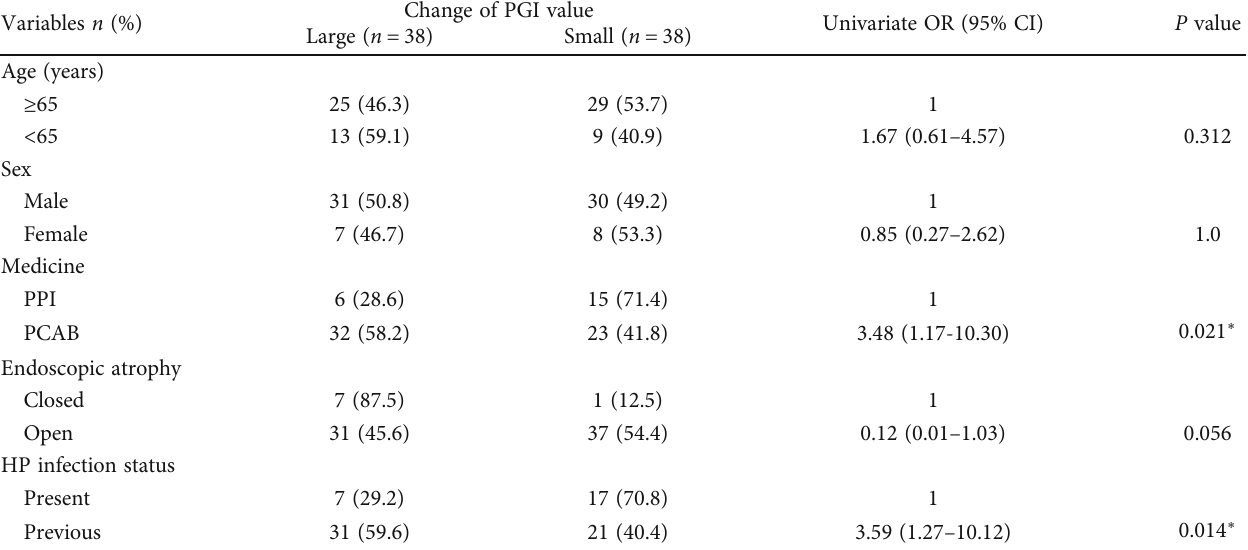
Table 4: Univariate analysis of the host factors that contribute to serum PGI level alterations.